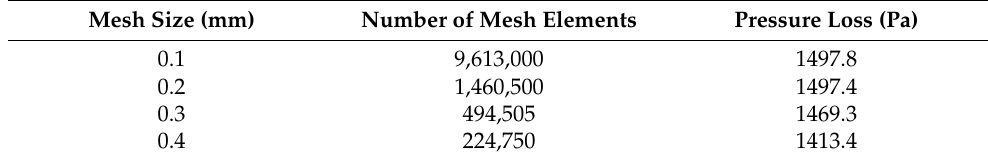
Table 1. Simulation results of pressure loss for mesh with different